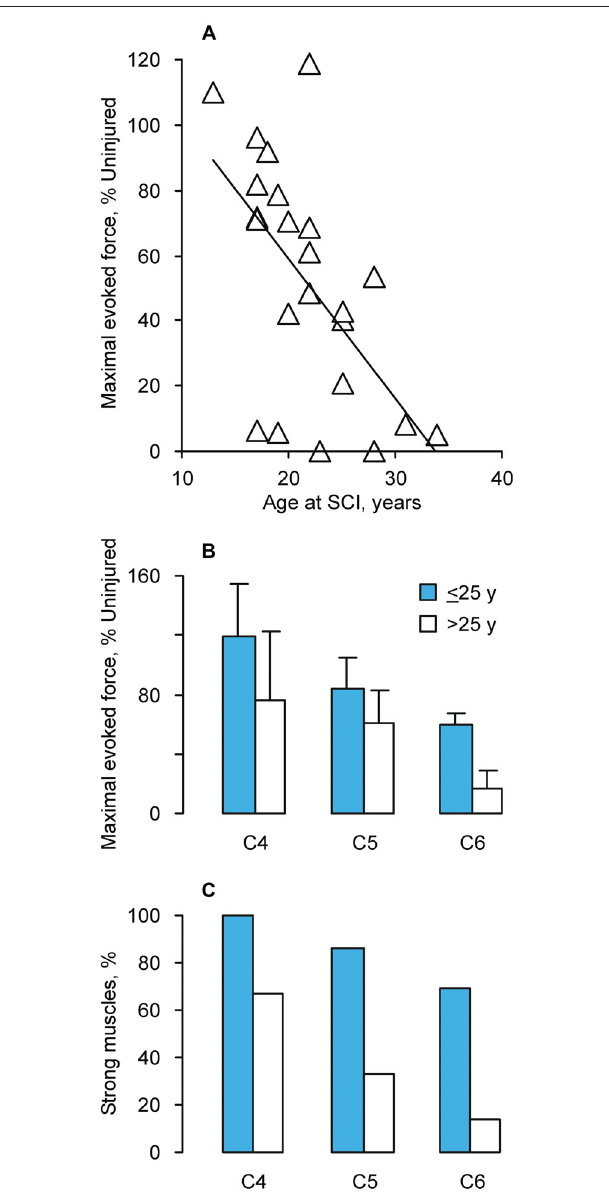
FIGURE 1 | (A) Maximal evoked force vs. age at which C6 SCI occurred ( n = 23 muscles; y = − 4.28 x + 145.07, R 2 = 0.36). Mean ( + SE) forces for uninjured 20 and 30 year old men were 26.7 ± 1.6 N and 22.9 ± 4.2 N, respectively. The corresponding data for women were 16.4 ± 1.7 N and 18,7 ± 1.8 N. (B) Mean ( ± SE) maximal evoked thenar force ( n = 42 muscles) normalized to age and sex-matched uninjured data ( n = 40 muscles). (C) Percentage of strong muscles ( > 50% uninjured force), separated by SCI level and age at SCI (Younger: ≤ 25 years; Young: > 25 years; n = 42